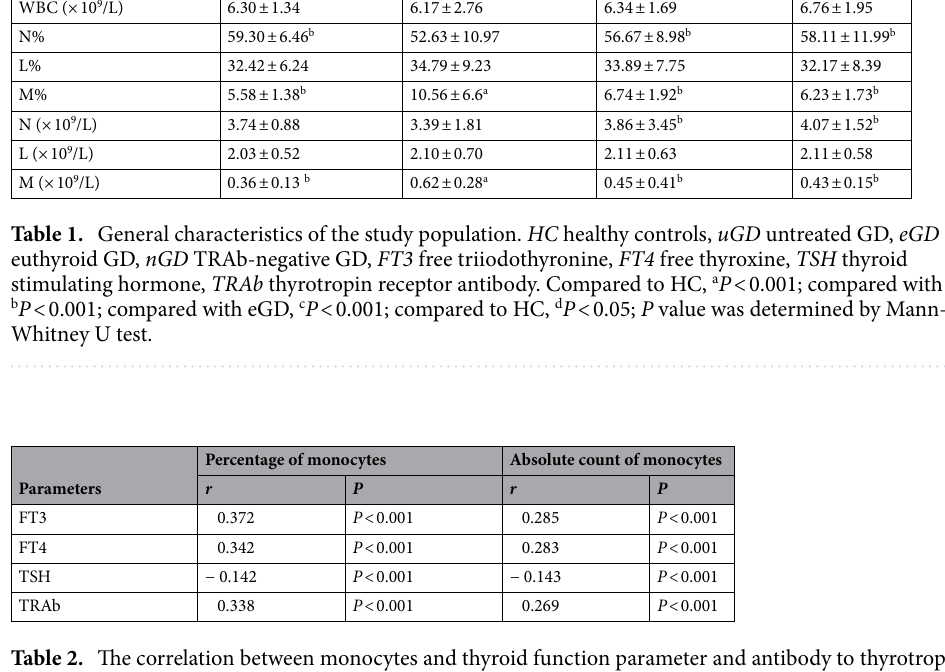
Table 2. The correlation between monocytes and thyroid function parameter and antibody to thyrotropin receptor (TRAb) in Graves’ disease. Correlations were analyzed via Spearman’s correlation analysis. FT3 free triiodothyronine, FT4 free thyroxine, TSH thyroid stimulating hormone, TRAb thyrotropin receptor antibody.